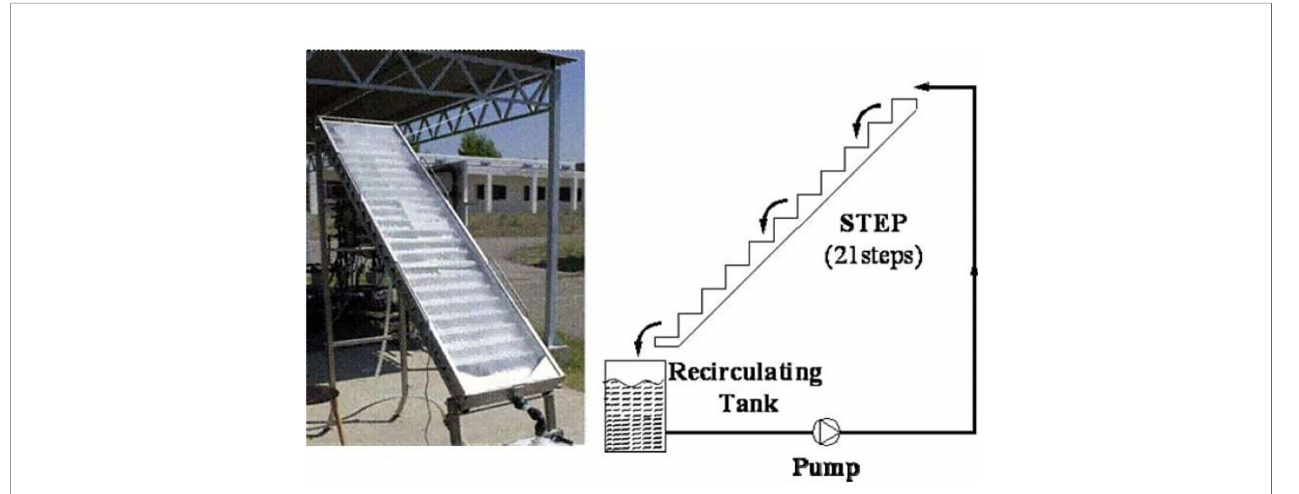
FIGURE 10 | Non-concentrating STEP solar collector tested at Platforma Solar de Almeria (SPAIN). Reproduced with permission (Malato et al.,